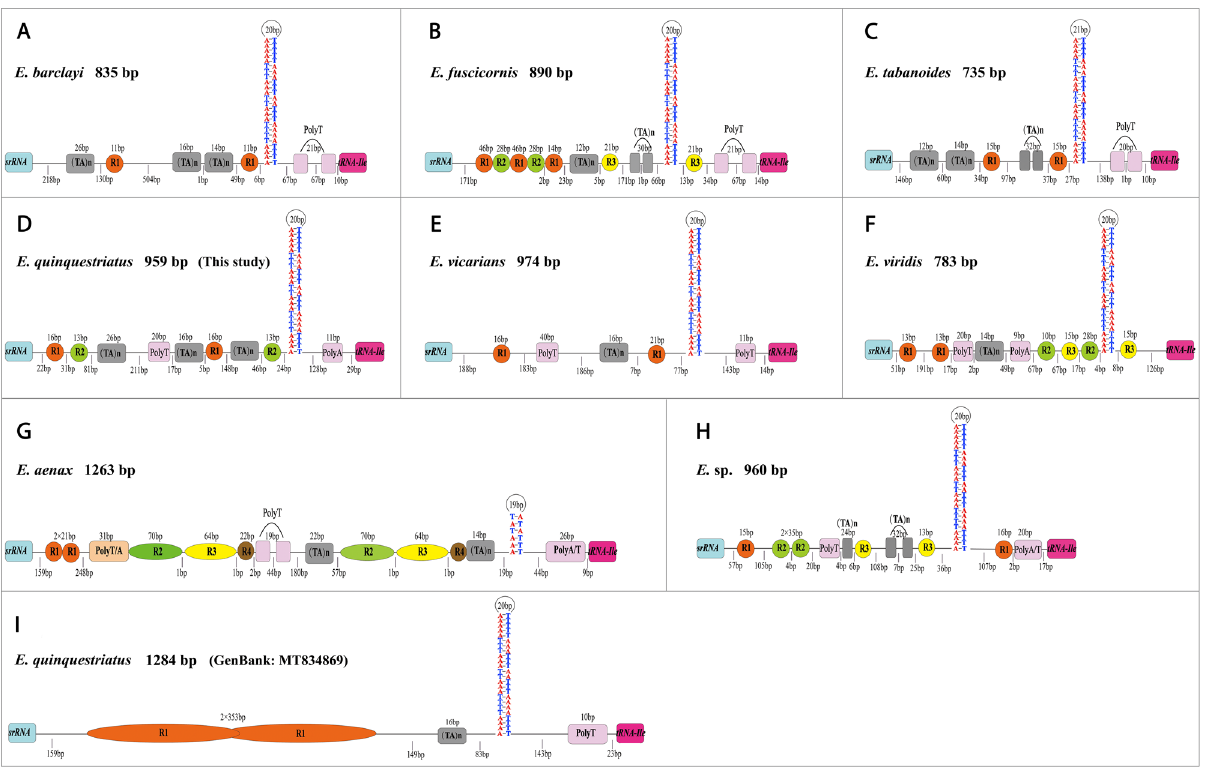
Figure 7. Control Regions (CRs) of Eriatalinus . ( A ) E. barclayi , ( B ) E. fuscicornis , ( C ) E. tabanoides , ( D ) E. quinquestriatus , ( E ) E . vicarians , ( F ) E. viridis , ( G ) E. aenax , ( H ) E. sp., ( I ) E. quinquestriatus . Different shapes and colors represent the different kinds of sequences. “R” refers to repeat units. The image was predicted by Geneious Prime 2019 (www. genei ous. com), drawing with Adobe Illustrator